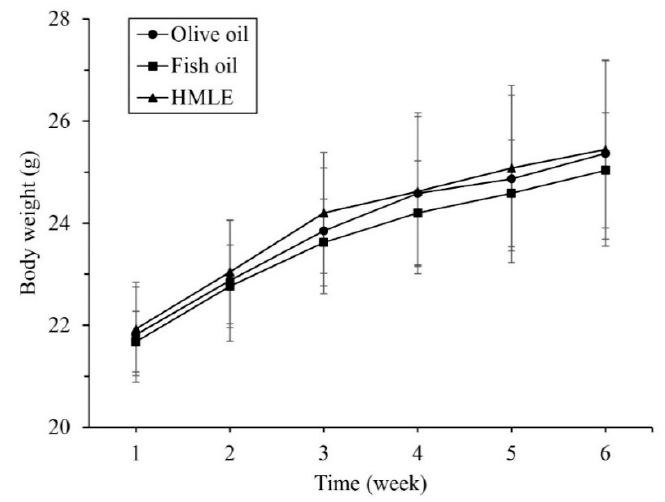
Figure 2. Changes in the body weight of mice. Data are represented as the mean ± SD.